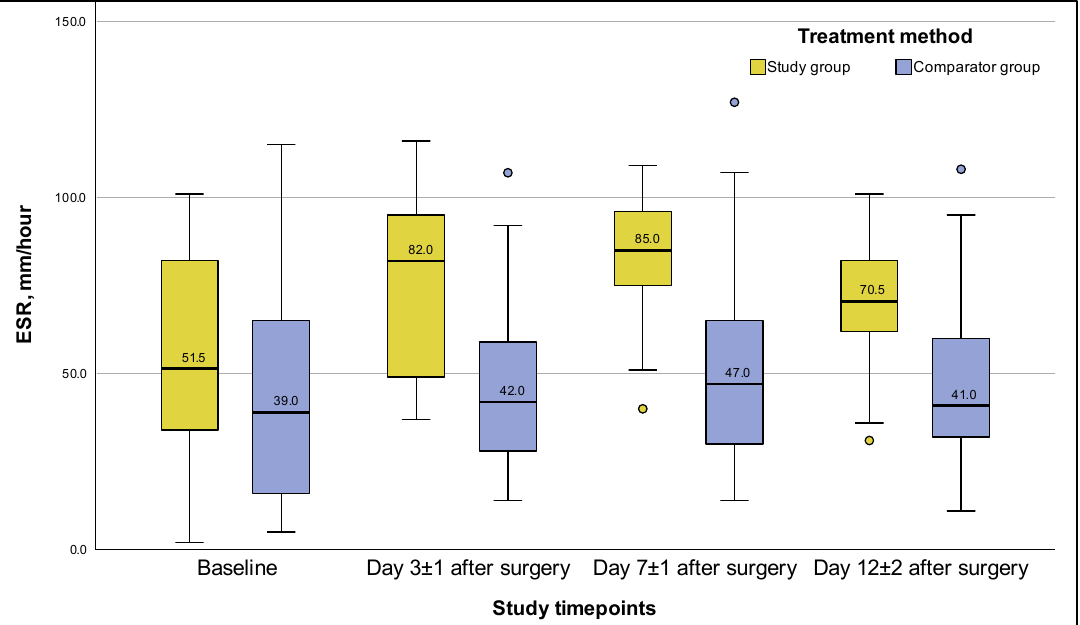
Figure 4. ESR values during PJI treatment for 12 ± 2 days after surgery (ITT population). Note: whiskers are based on 1.5 interquartile range, circles are outliers.